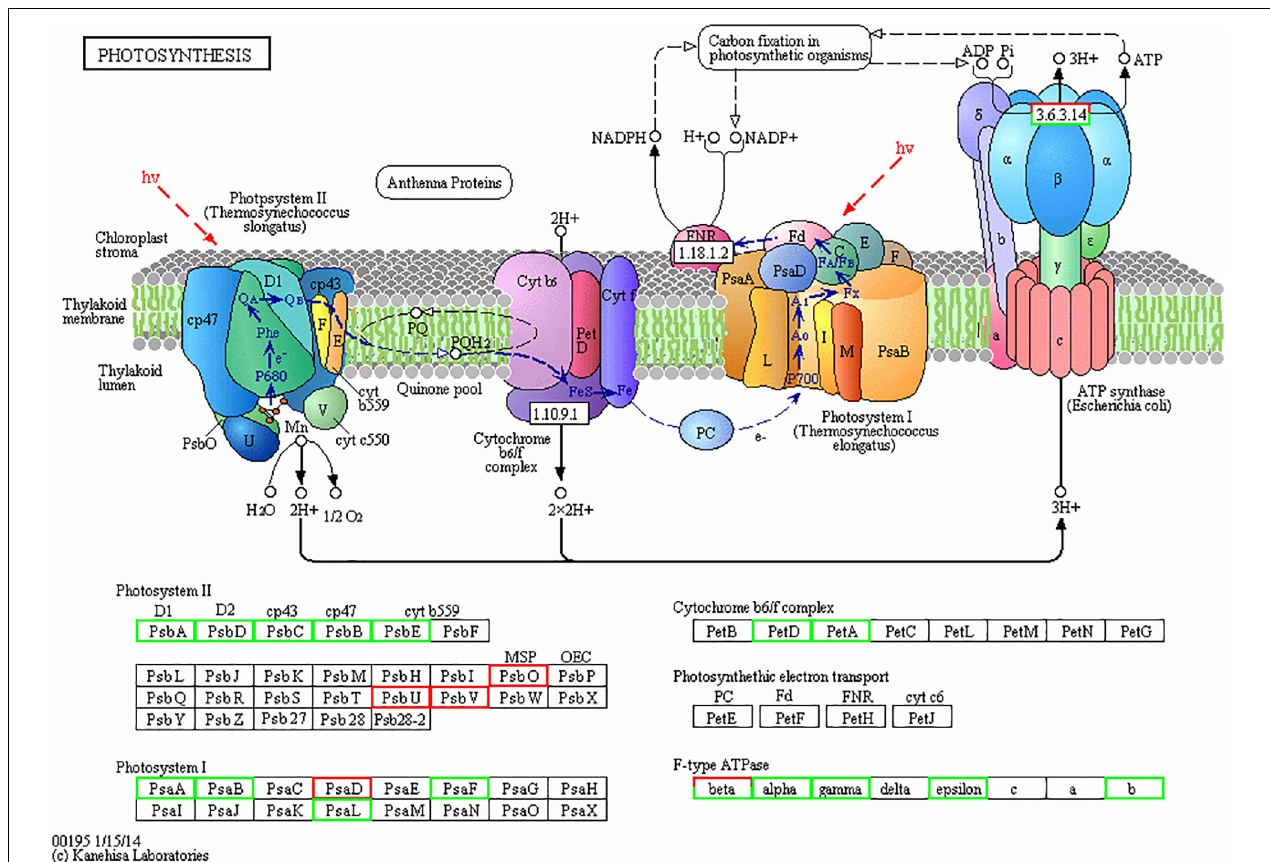
FIGURE 6 | The photosynthesis pathway map for Skeletonema dohrnii during the changes of temperature and silicate (HTHS vs. HTLS). The down-regulated proteins were shown in light green color boxes and up-regulated proteins are given in red color. The comprehensive information of all the regulated proteins associated with photosynthesis metabolism are given in Supplementary Tables S2, S3 . This image is obtained from KEGG website (http://www.kegg.jp/kegg/kegg1.html) with copy right